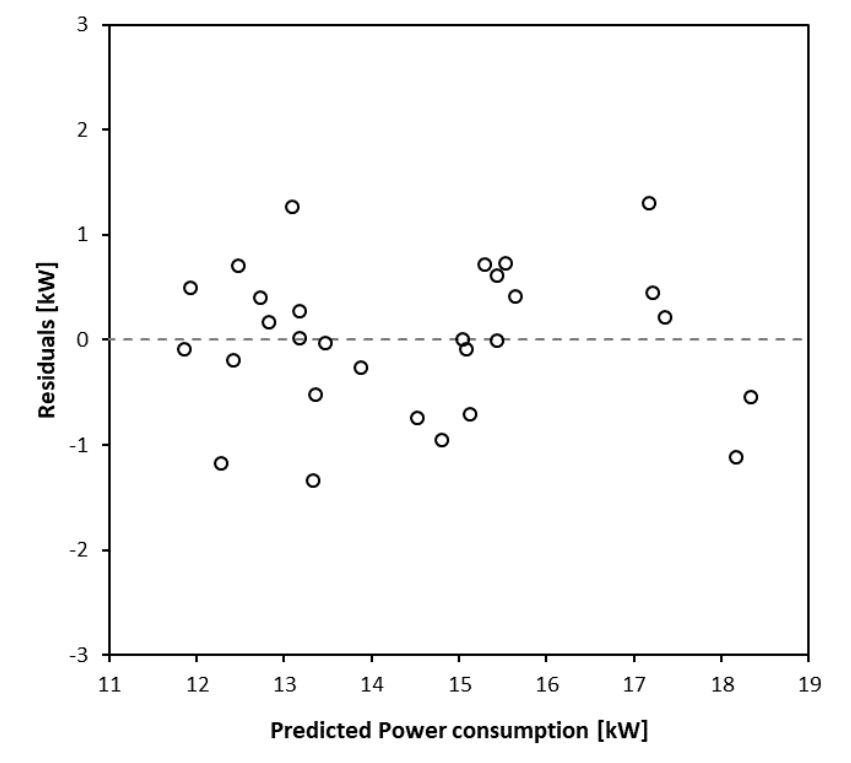
Figure 12. Residuals plotted by power